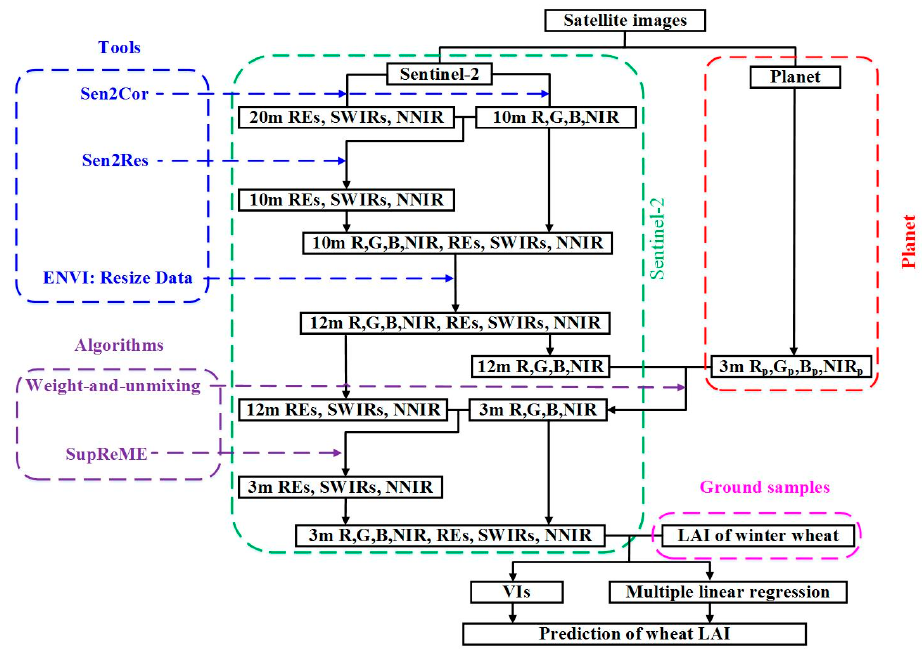
Figure 2. Flowchart of fused image processing and wheat LAI prediction.